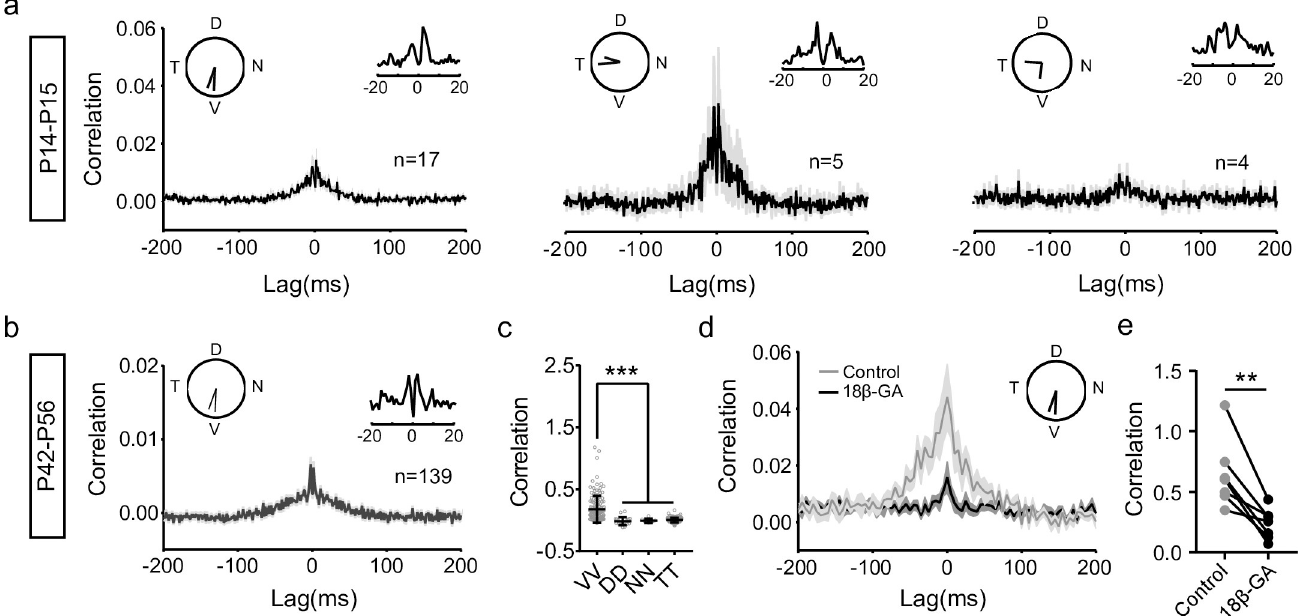
Fig 1. Electrical coupling among ooDSGCs during development. (a) Spike time cross-correlograms for ooDSGC pairs in the juvenile mice (P14–P15). Solid black line, average cross-correlogram across all recorded pairs of the specified combination. Shaded area, SEM. For each panel, the inset on the left indicates the ooDSGCs pair; inset on the right is a close-up view of the cross-correlogram with 1-ms bin size. The total numbers of recorded pairs are also indicated on the graph. (b) The same as (a), for V-DSGC pairs in adult mice (P42–P56). (c) Comparison of total spike time correlation among V-V, D-D, N-N, and T-T DSGC pairs in adult mice. Only V-V pairs show significant correlated activity. V-V, n = 139; D-D, n = 22; N-N, n = 8; T-T, n = 172. ��� p < 0.001. Error bars: SD. (d,e) Gap junction blocker 18 β -GA largely blocks the correlated activity among V-DSGCs. (d) Comparison of the average cross-correlograms. Gray, control; black, 18 β -GA. n = 7 pairs. Bin size, 5 ms. (e) Paired comparison of the correlation using the same data as in (d). Correlation is calculated as the sum of cross-correlation from − 100 ms to 100 ms with 1-ms time bin. For every pair tested, a reduction in correlated activity is induced with 18 β -GA. �� p < 0.01, paired t test. Data for this figure are in S1 Data. ooDSGC, ON-OFF direction selective ganglion cell; T, temporal-preferring direction selective ganglion cell; V, ventral-preferring direction selective ganglion cell; 18 β -GA, 18 β -glycyrrhizic acid.